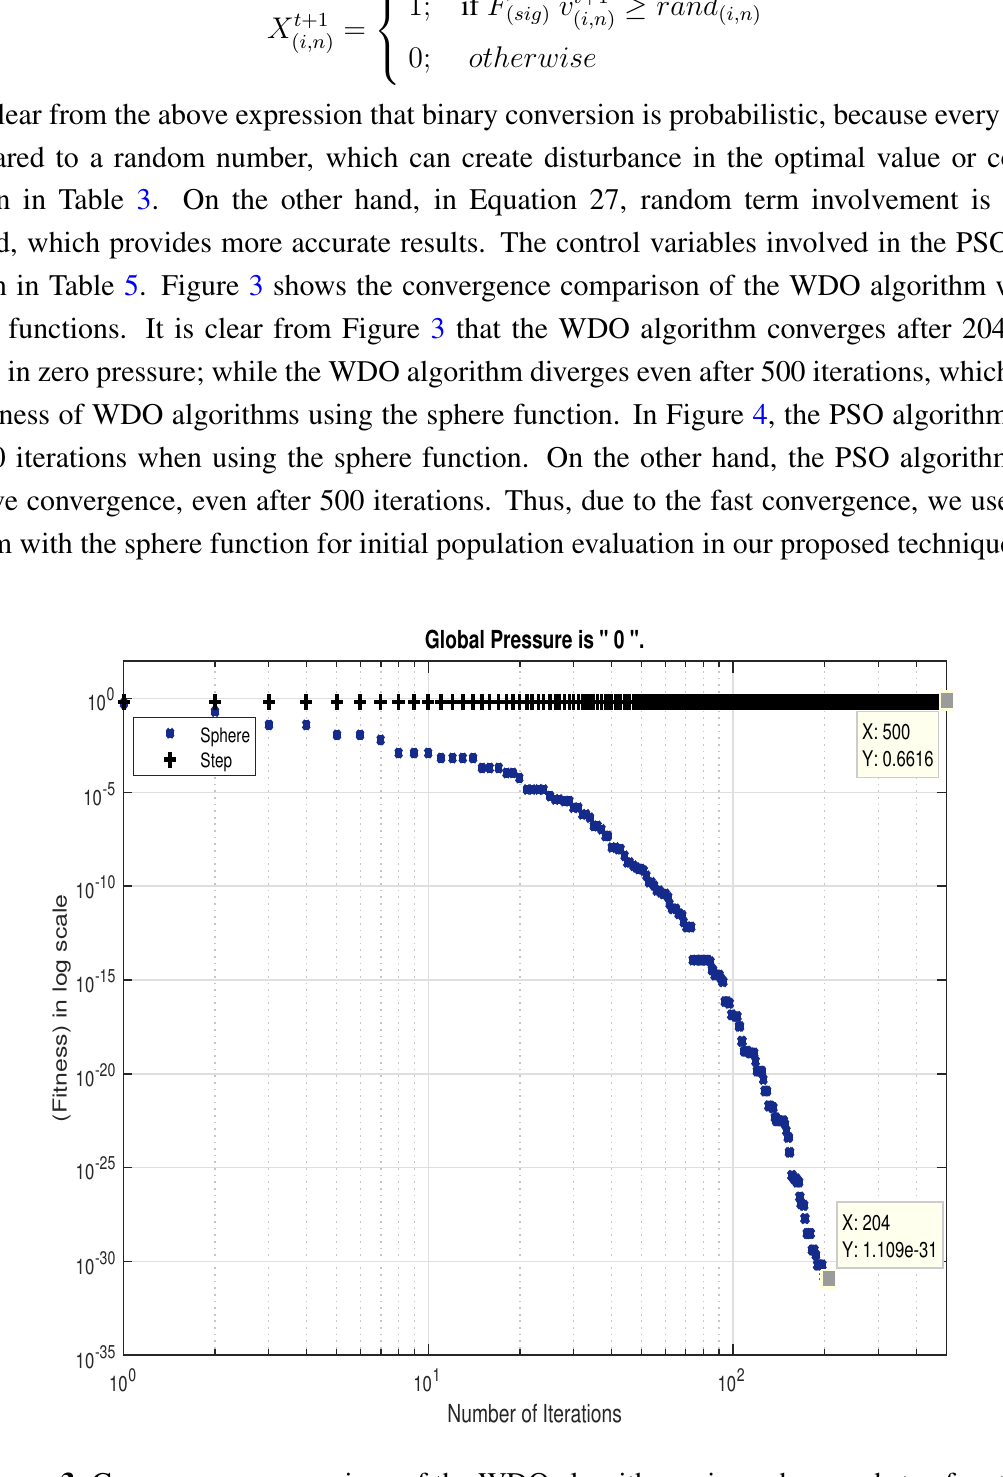
Figure 3. Convergence comparison of the WDO algorithm using sphere and step